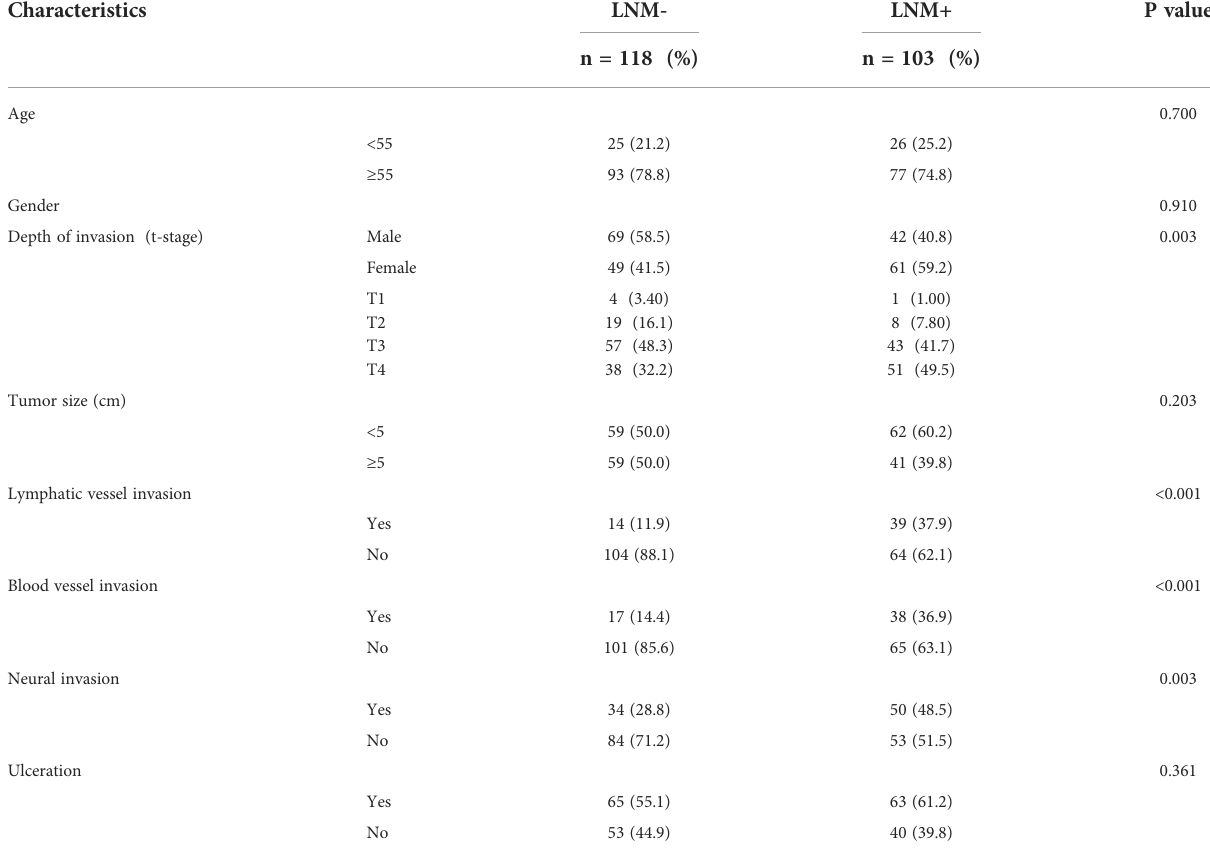
TABLE 1 Characteristics of CRC patients in the validation